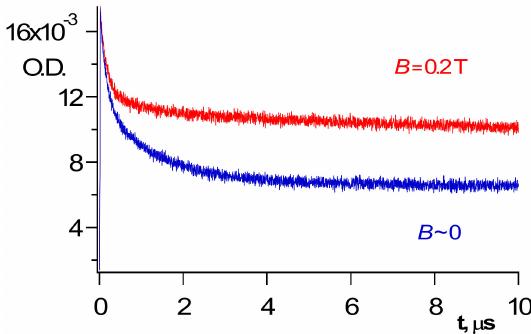
Figure 3. Kinetic traces of transients at λ 545 nm measured in E. BH • decay was measured within G-pairs (Scheme 3) in the Earth’s MF and in the external MF. Adapted from Ref. [24]; see this Ref. for details.